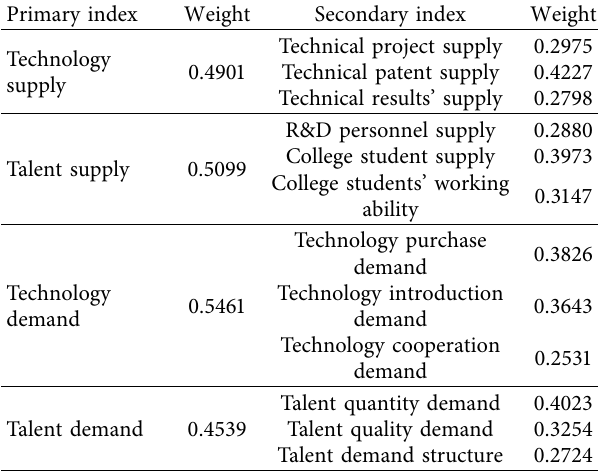
Table 2: Weights of evaluation